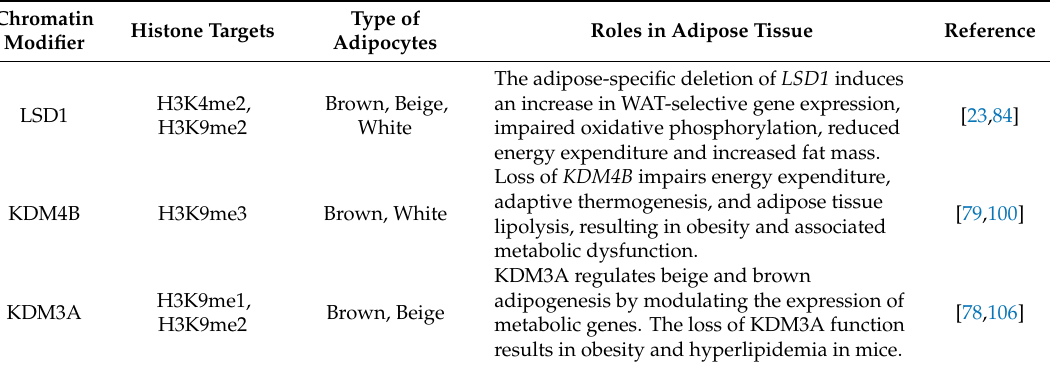
Table 1. Histone lysine demethylases involved in adipogenic development and its relation to